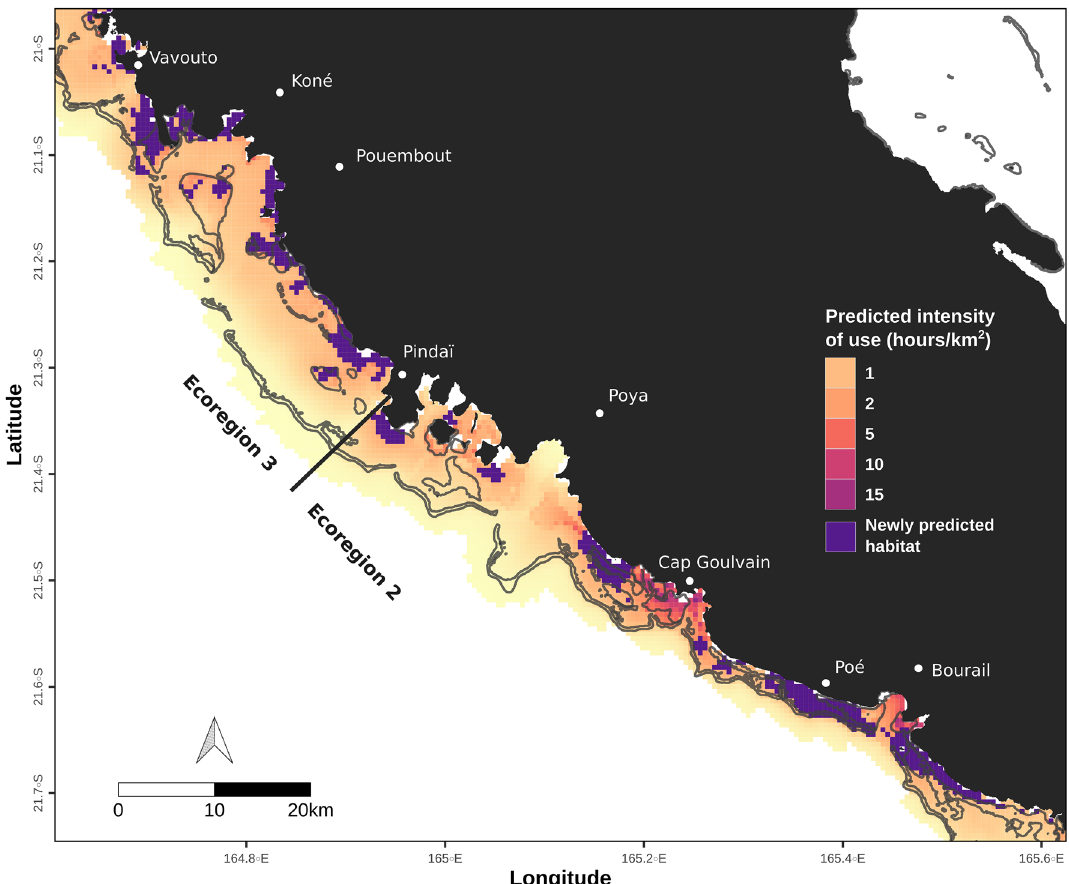
Figure 4. Map of predicted intensity of use zoomed over the northern border between ecoregions 2 and 3, overlaid with newly predicted habitats as revealed by cross-validation. Predicted intensity of use (h/km 2 ) is shown on a colored scale. Newly predicted habitats (i.e. areas predicted with highly suitable habitat but where density from aerial surveys was classified as low) are shown in purple. Land is represented in black and shallow reef contours in grey (shapefile source: Millenium Coral Reef Mapping Project 69,70 ). The map was created with R (version 3.6.3, www.r- proje ct. org 86 ).